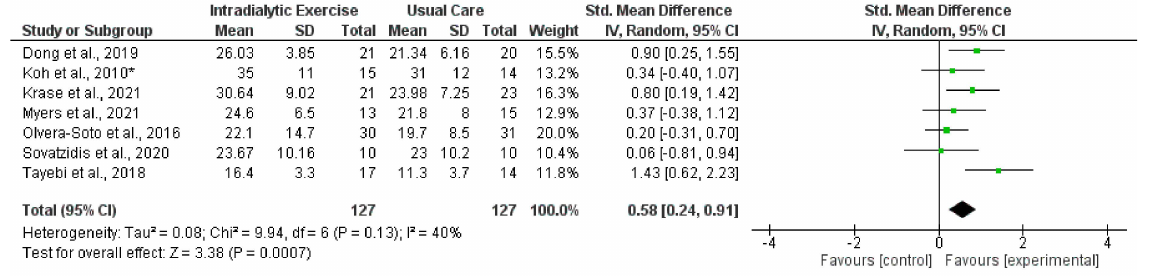
Figure 2. Effect of intradialytic exercise on grip strength in individuals receiving haemodialysis. Data are expressed as standardised mean difference and 95% CI. * Data for exercise and control groups only [17,25,29,30,34,38,39].